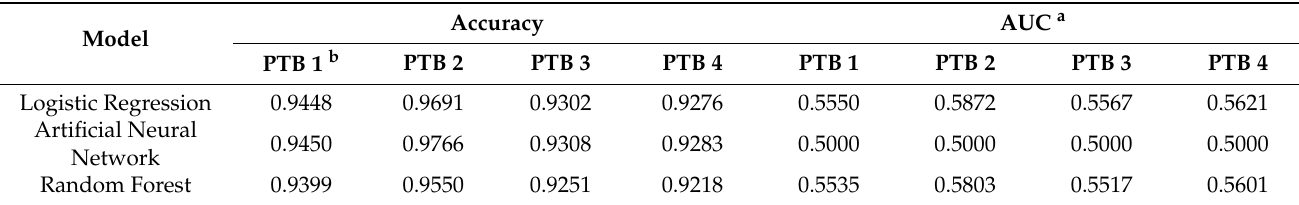
Table 3. Model performance with